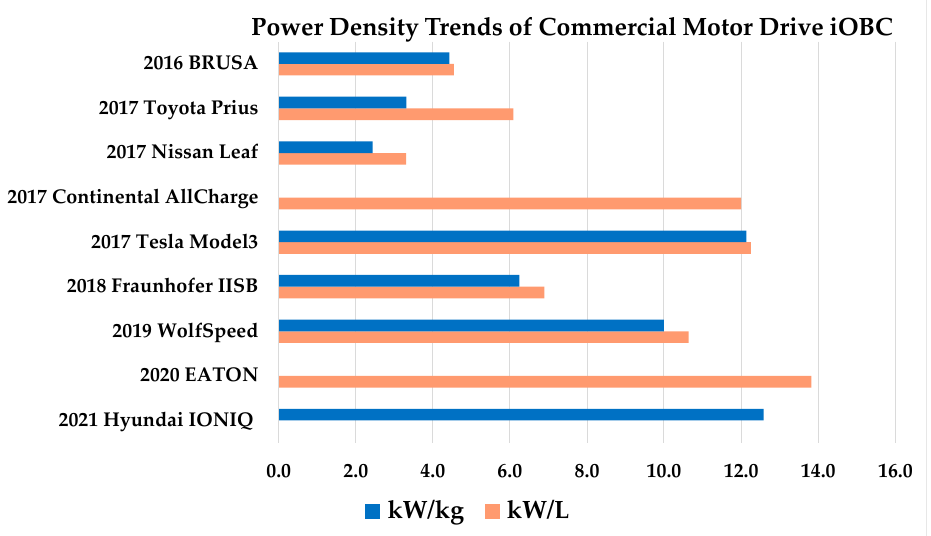
Figure 34. Estimated power density state of the art for commercially available integrated on-board chargers (iOBC).